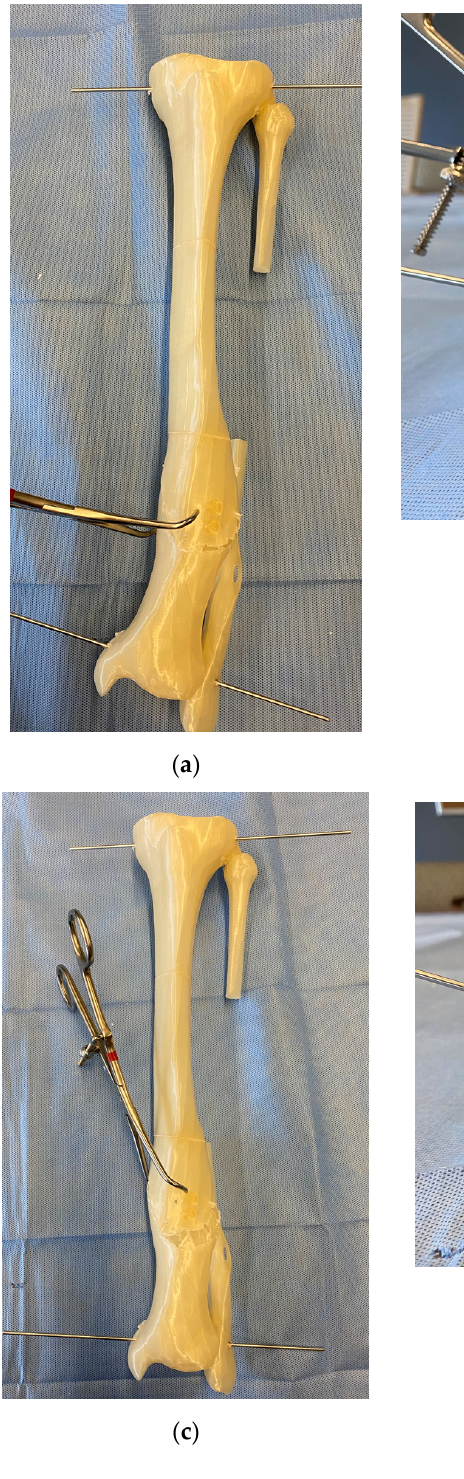
Figure 5. A 3D-printed model before ( a , b ) and after ( c , d ) a deformity correction with a mathemati- cally directed single-cut osteotomy. It allows for the simultaneous correction of angular and rota- tional deformity around one osteotomy plane. Note the change in the relative K-wire positions with the correction of the internal rotational deformity on the axial views. This 3D model represents the clinical example in case 2, where the calculation and execution of the mathematically directed oste- otomy are described.